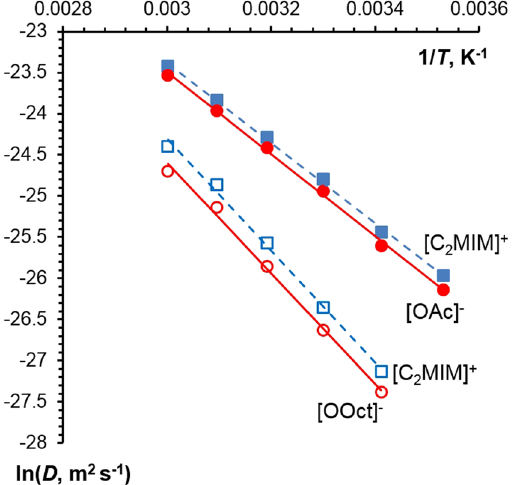
Figure 2. Self-diffusion coefficients for the cation and anion of both ILs as a function of the inverse temperature. Lines show linear fits. Uncertainty in D of 5% is approximately the size of points and has been omitted for